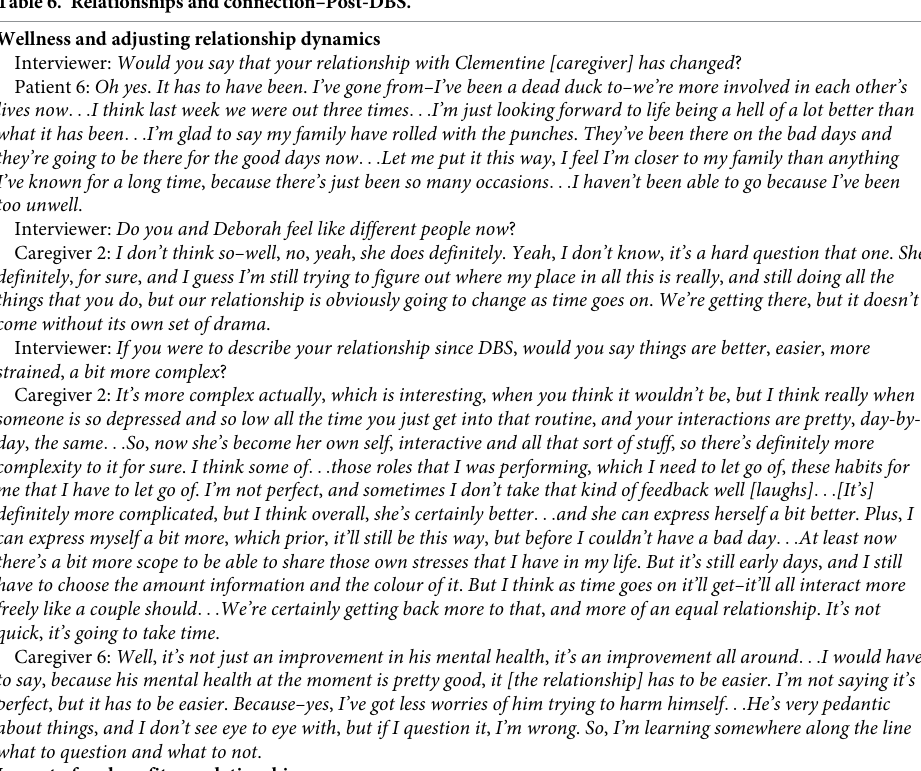
Table 6. Relationships and